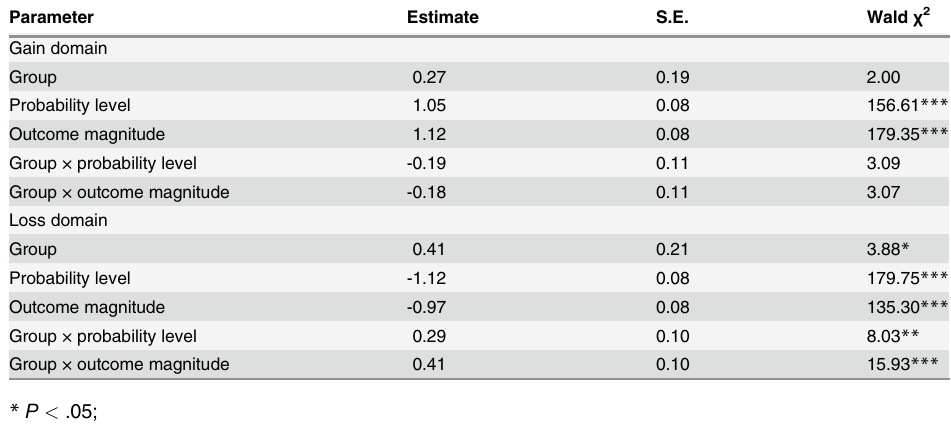
Table 2. Effect of probability level and outcome magnitude on risk taking as a function of domains and